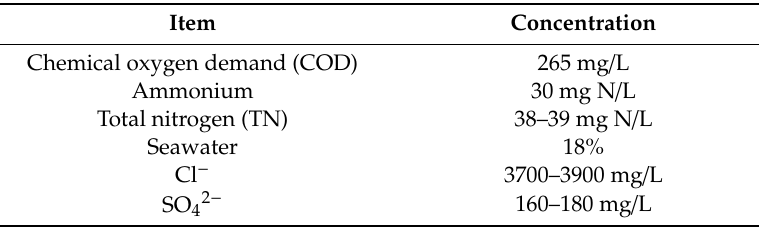
Table 1. The synthetic wastewater composition.